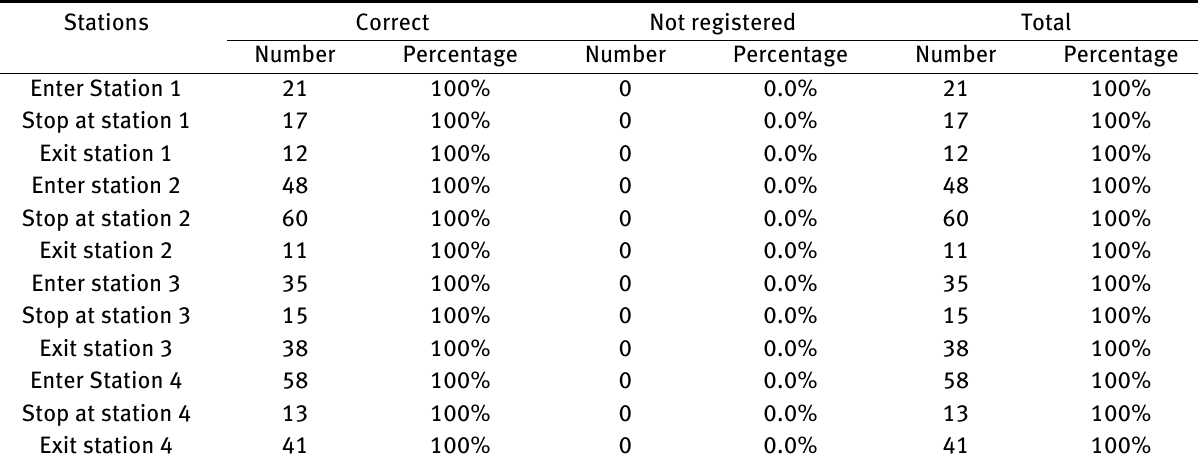
Table 4: Test the normality of the data Stations Kolmogorov-Smirnov Shapiro-Wilk Statistic DF Sig. Statistic DF